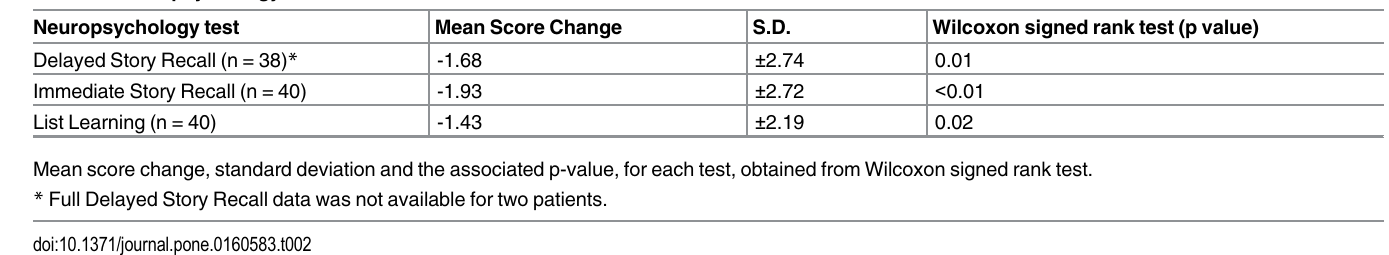
Table 2. Neuropsychology test score